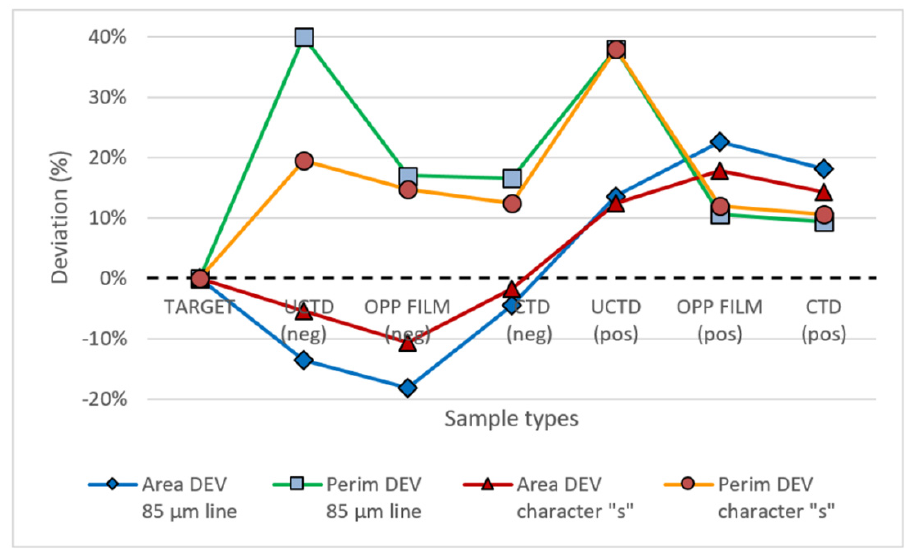
Figure 7. The comparison of area and perimeter deviation (%) for character “s” 8 pt size and line 85 µ m thickness printed in positive and negative shape on three different printing substrates.